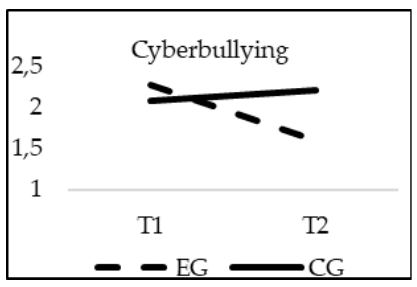
7 of 13 Figure 1. Interaction effects of group (EG-CG) and time (T1-T2) in Bully Behavior. Figure 2. Interaction effects of group (EG-CG) and time (T1-T2) in Peer Victimization. Figure 3. Interaction effects of group (EG-CG) and time (T1-T2) in Fighting. 3.3. Effectiveness of the Intervention in Cyberbullying Reduction With respect to Cyberbullying, a significant interaction effect of group*time was found for Cyberbullying (E-Bullying Scale) (F (1, 20) = 12.382; p = 0.000; η 2 = 0.006), and Cybervictimization